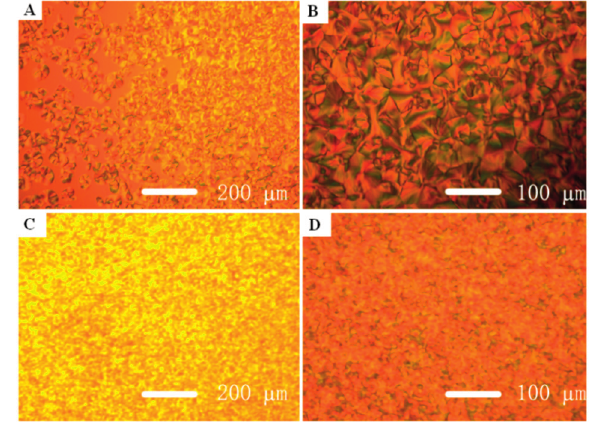
Figure 9. Polarized optical micrographs (POM) of poly( ε -caprolactone) (PCL) crystallized at 30 °C. ( A ) and ( B ): the linear poly( ε -caprolactone) (P1, M n GPC = 7400 g/mol, M w / M n = 1.15); ( C ) and ( D ): the hyperbranched poly( ε -caprolactone) (HPCL, M n GPC = 25,500 g/mol, M w / M n =